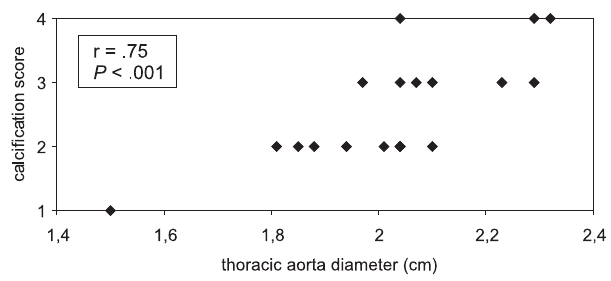
Figure 3 - Scatter plot graph of the diameter of the thoracic aorta versus calcification score